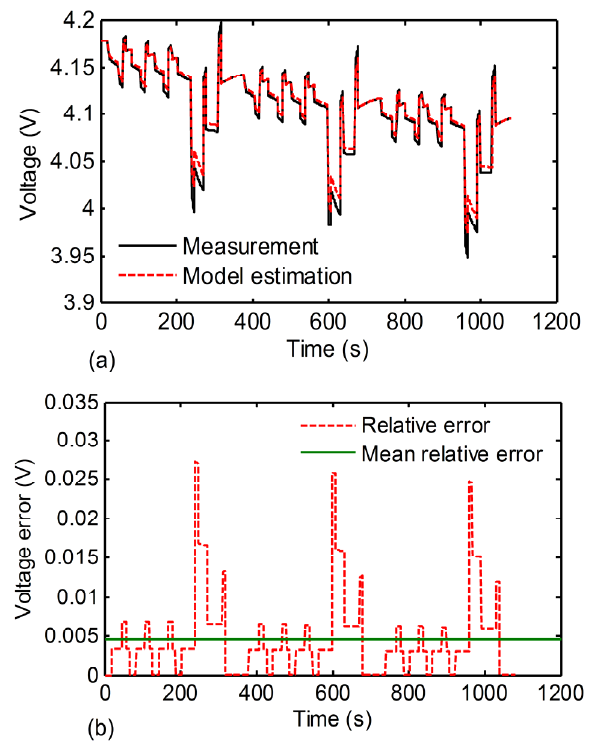
Figure 6. Voltage profiles in the first three DST cycles: ( a ) voltage; ( b ) voltage